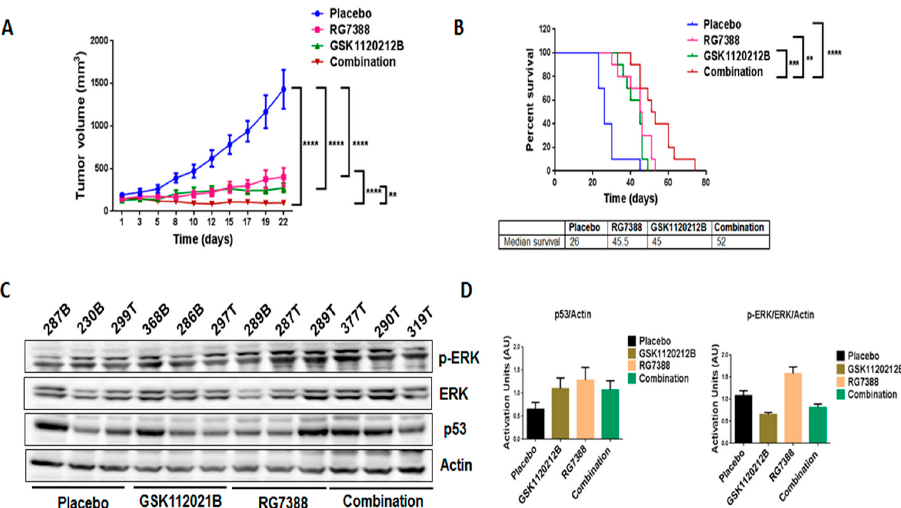
Figure 4. Combination treatment of GSK1120212B and RG7388 resulted in decreased tumor volume and increased survival of mice. ( A ) Effect of GSK112021B and RG7388, alone or in combination, on tumor growth. ( B ) Kaplan–Meier curve depicting overall survival of mice treated with GSK1120212B and/or RG7388. ( C ) Representative blots of tumor tissues from mice treated with GSK112021B, RG7388, or the combination and immunoblotted for p-ERK, ERK, and p53. ( D ) Quantification of blots of tumor tissues from mice treated with GSK112021B, RG7388, or the combination. ** p ≤ 0.01, *** p ≤ 0.001, and **** p ≤ 0.0001.